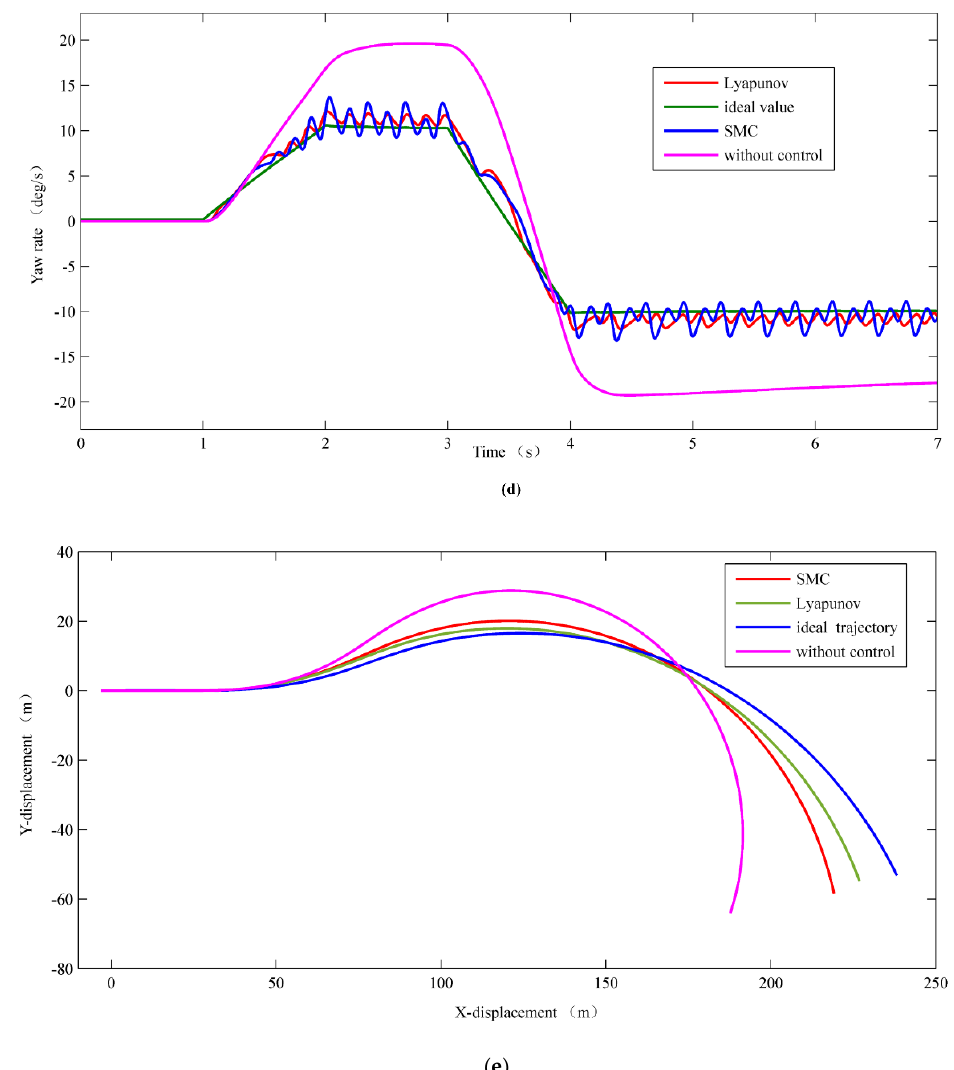
Figure 5. Fishhook test results: ( a ) steering wheel angle; ( b ) yaw moment response curve; ( c ) control results of sideslip angle; ( d ) control results of yaw rate; ( e ) path trajectory.